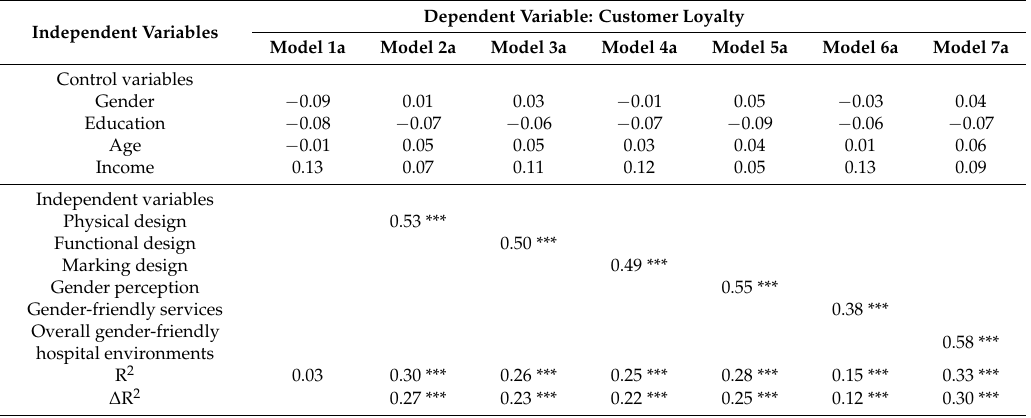
Table 6. Regression analysis for the effects of gender-friendly hospital environments on customer loyalty.